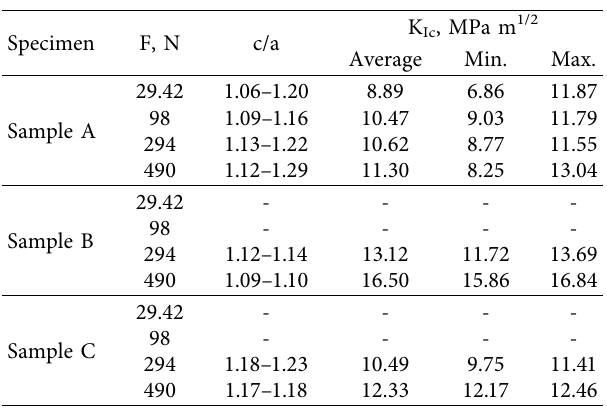
Table 1: Statistical analysis of the indentation fracture toughness (K Ic ) of nitrided AISI 4140 steel as a function of the test load, using the equation of Shetty et al.